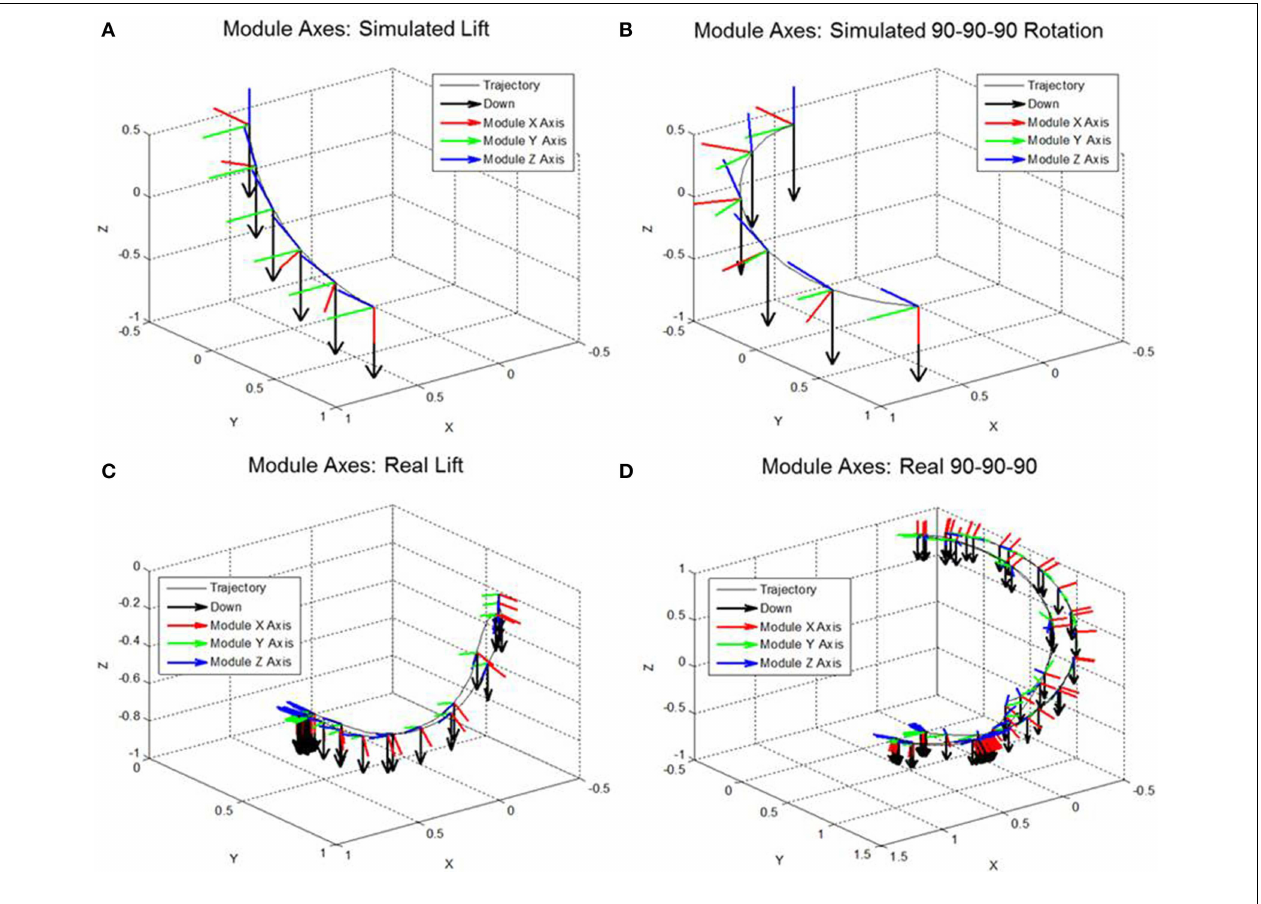
module axes in the inertial coordinate frame over the course of the motion are depicted as well as the trajectory of the module and the direction of inertial